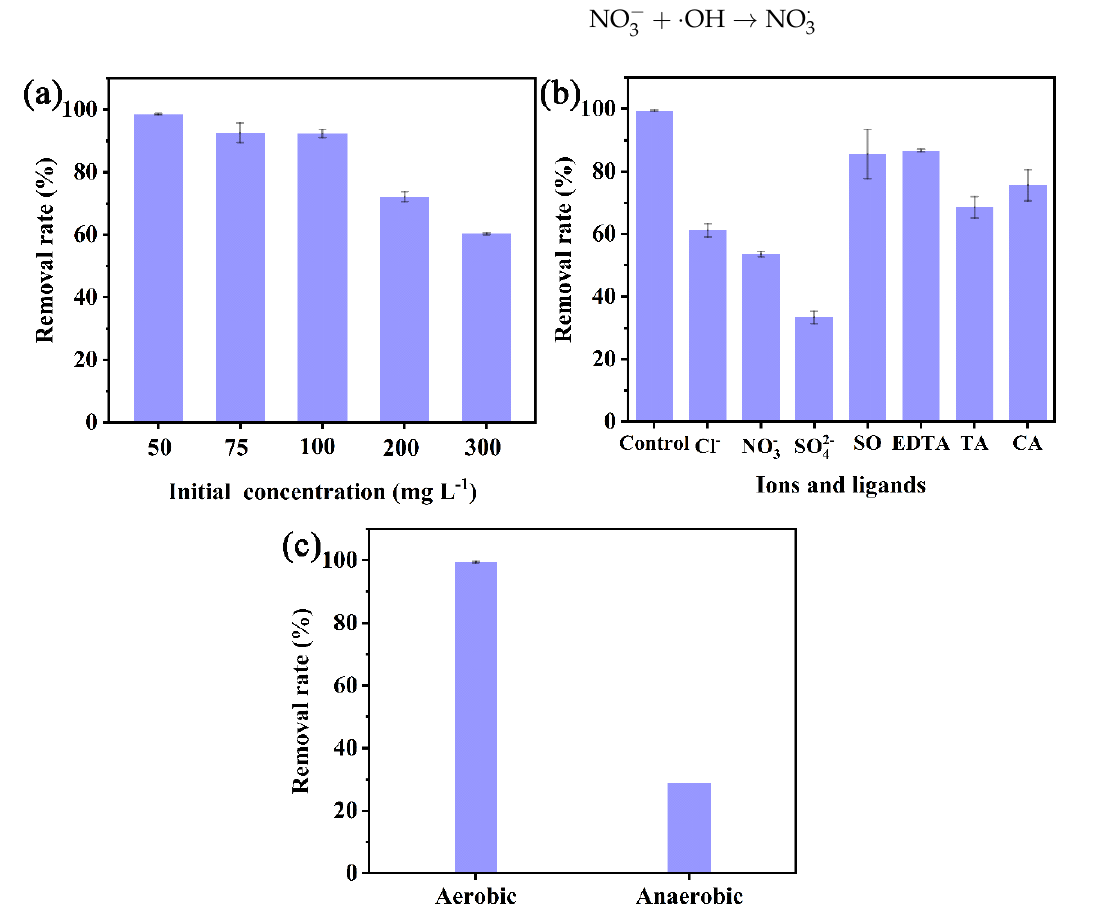
Figure 4. Effect of CIP initial concentration ( a ), co-existing ions and organic ligands ( b ), and DO ( c ) on CIP removal.